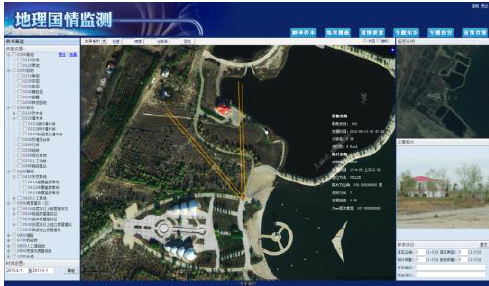
Figure 5. The interface of the crowdsourcing update and open evaluation